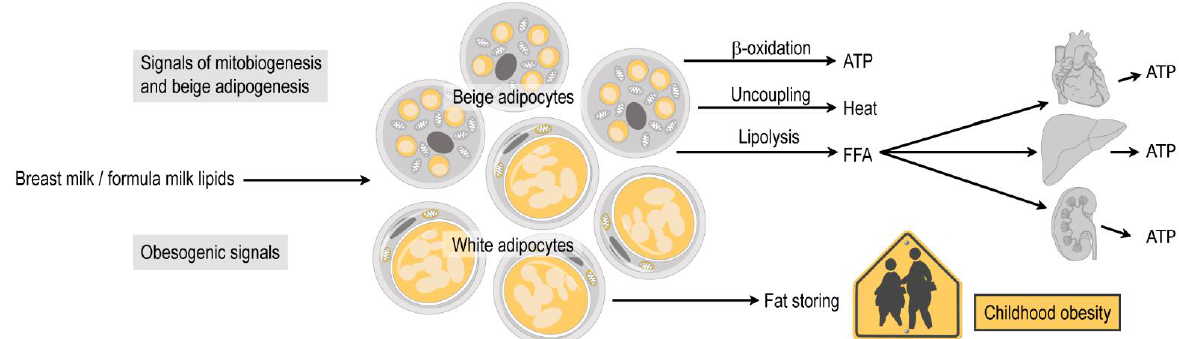
Figure 3. Duality of lipid metabolism in the infant subcutaneous adipose tissue. The adipose tissue in the infant has mitochondria-rich “beige” or “brown” adipocytes and fat storing “white” adipocytes. The beige or brown adipocytes actively break down neutral lipids, and oxidize fatty acids via mitochondrial β oxidation to produce ATP, or use fatty acids to generate heat from uncoupled terminal electron transport of the mitochondria. Moreover, they release free fatty acids (FFA) into the blood circulation, which are used by energy-demanding organs, such as the heart, the liver and the renal cortex to produce ATP. White adipocytes have lipogenic activity and build up lipid stores. Breast milk lipid signals sustain the differentiation of beige/brown adipocytes. When the amount of the beige/brown adipocytes decreases (for instance, due to insufficient breastfeeding or in response to obesogenic signals), childhood obesity develops.